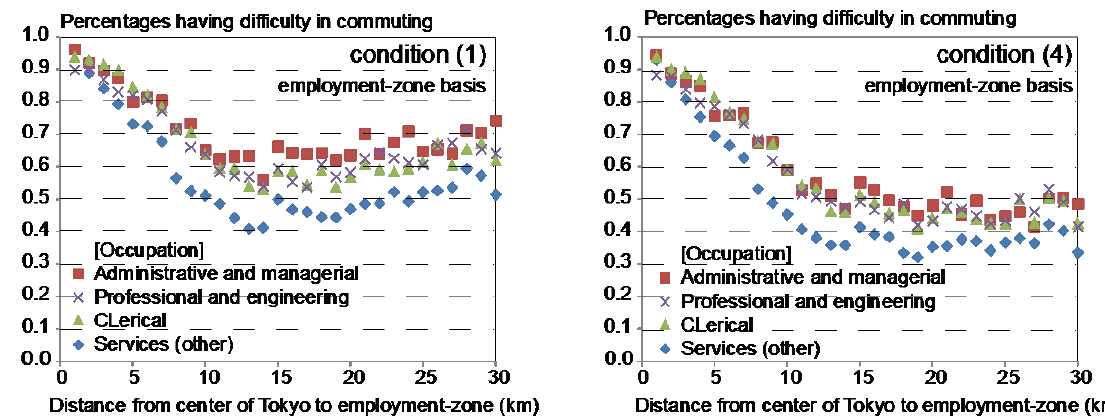
Figure 17. Percentages of commuting difficulty versus distance of employment zone from the center of